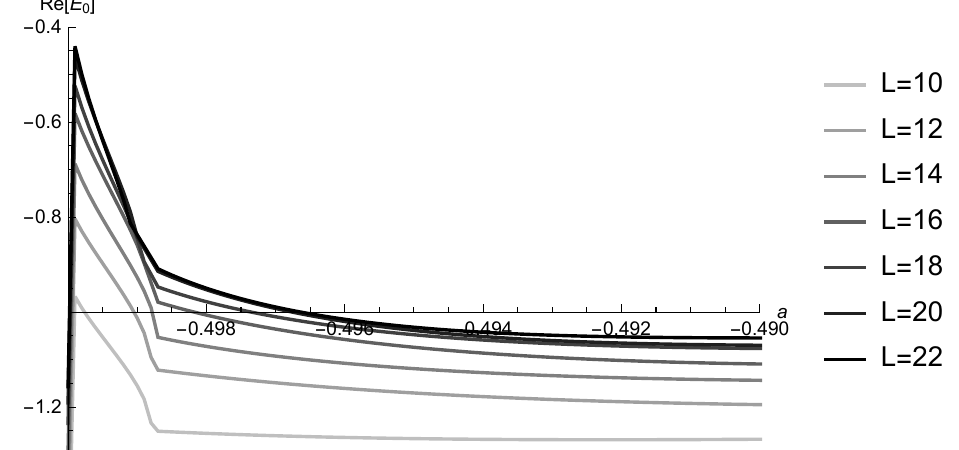
Figure 13 . Plots of the real part of the gauge invariant observable E 0 (2.17) for the “ghost brane” solution Φ G near a = − 1 / 2 at the truncation level L = 10 , 12 , · · · , 22 . The horizontal axis denotes a the value of the parameter a at Re E 0 = − 1 . The vertical axis stands at a = − 1 / 2 .